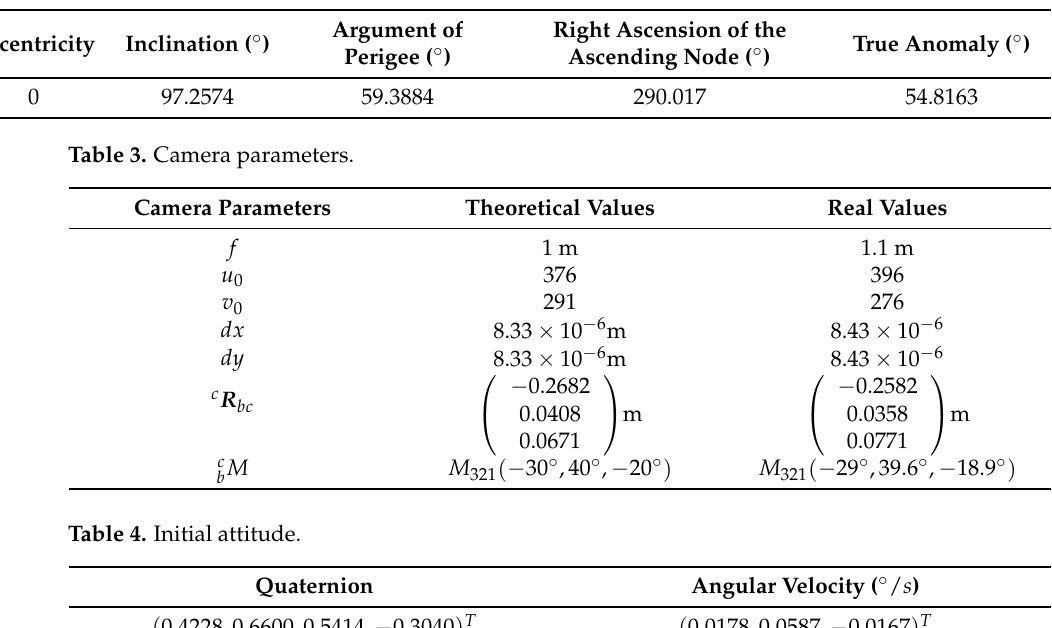
Table 2. Orbital elements.